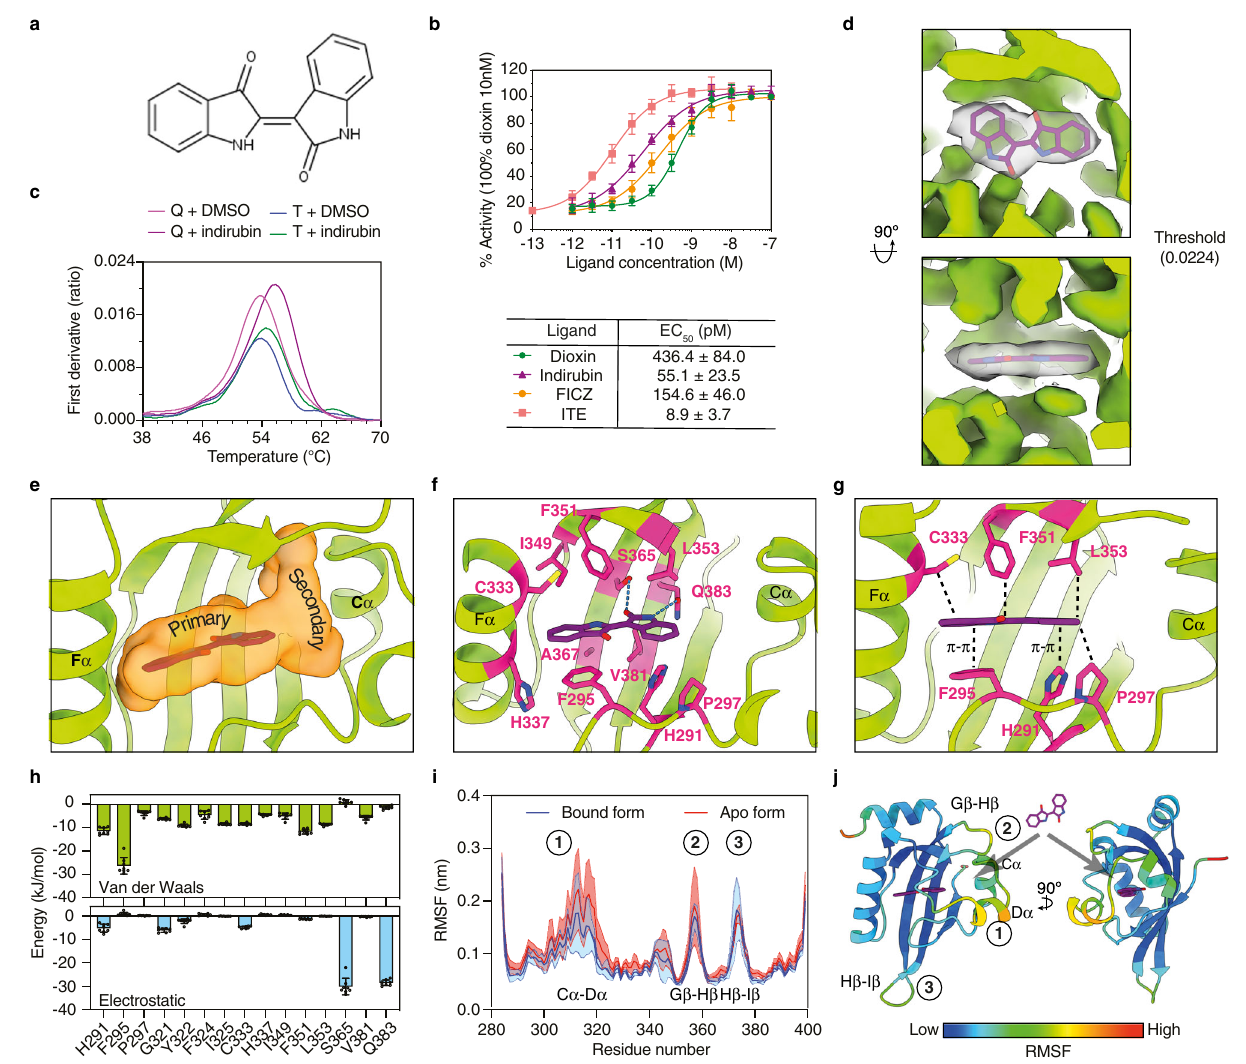
Fig. 6 | Characterization of the interaction with indirubin. a Structure of indir- ubin. b Results of cell-based activity assays for four AHR ligands. The results are represented as mean value±SD from independent biological replicates ( n =4). c Nano-DSF analysis of the interaction between Hsp90-XAP2-AHR (T, ternary) and Hsp90-XAP2-p23-AHR (Q, quaternary) complexes and indirubin. The results are representativeofindependentbiologicalreplicates( n =3). d Twoorthogonalviews of the cryo-EM map for the region corresponding to indirubin. e Close-up view of the ligand binding pocket(LBP) shown asanorangesurface. f Close-up view of the indirubin binding site. Residues interacting with the ligand are shown as magenta sticks. Hydrogen bonds are indicated as dashed blue lines. g Two layers of LBP